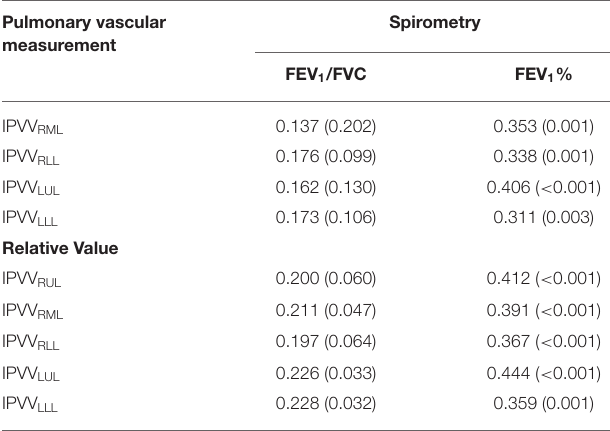
Frontiers in Medicine |